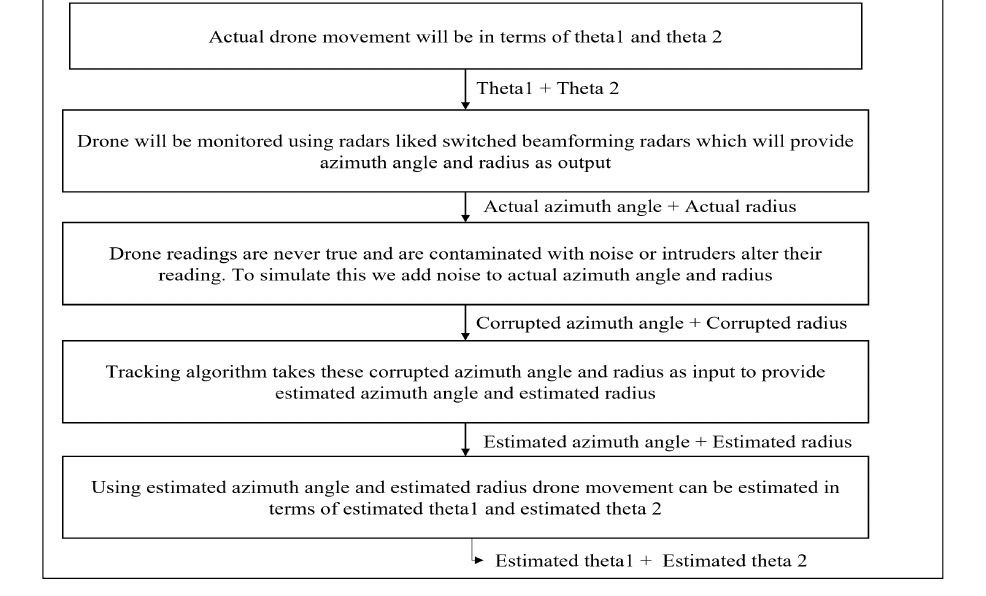
Figure 7. Flowchart for UAVs/drones position tracking.